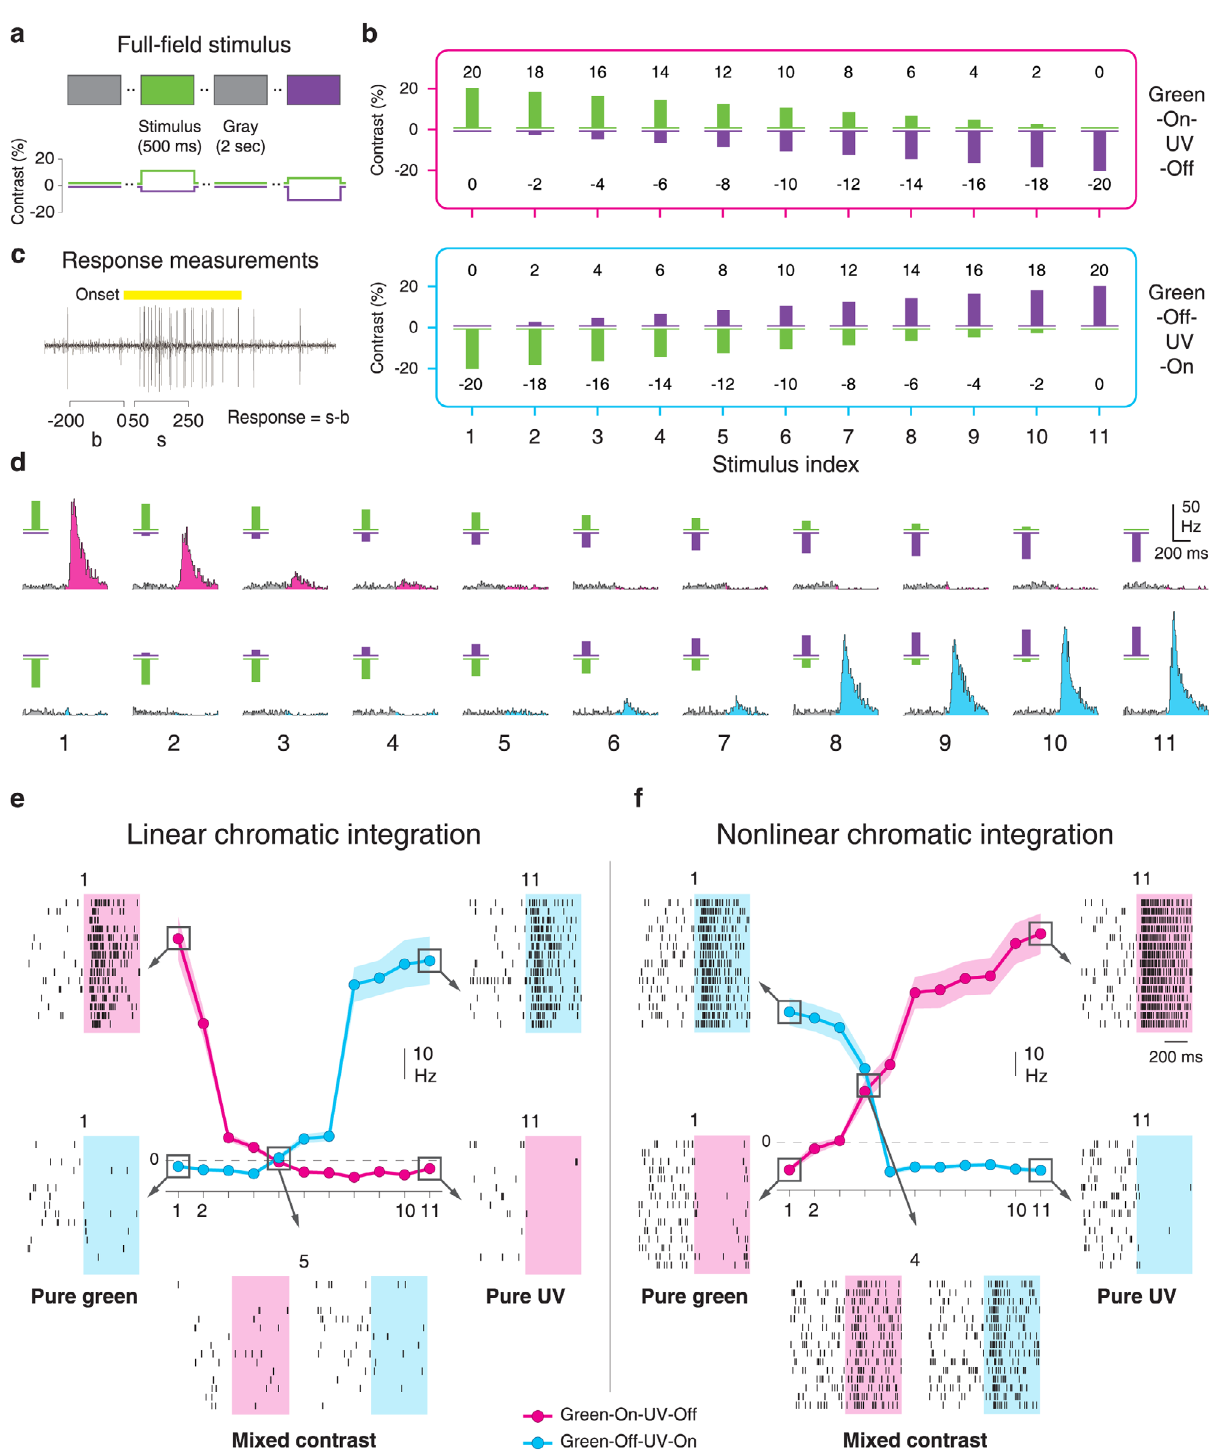
Fig. 2 Measurement of chromatic integration. a Schematic representation of the chromatic-integration stimulus. 500-ms presentations of opposing contrast of UV and green were interleaved with 2 s of background illumination (gray). b Schematic depictions of all contrast combinations used for assessing chromatic integration. The contrast combinations are arranged into two sets, corresponding to green-On-UV-Off (magenta box, top) and to green-Off-UV-On (blue box), with pairs of contrast-reversed combinations vertically aligned and assigned to a stimulus index (1 – 11). c Response measurements used for constructing the chromatic-integration curves. Spike counts (s) were obtained over a 200-ms window during stimulation (50 – 250 ms after stimulus onset), and the background activity (b), measured as the spike count during the 200 ms prior to the stimulus, was subtracted (s − b). The yellow bar shows the stimulus period. d PSTHs for a sample On cell responding to the contrast combinations of the chromatic-integration stimulus (below: stimulus indices 1 – 11). e Chromatic-integration curves for the same cell as in d , surrounded by exemplary raster plots for some of the contrast combinations. At the balance point, activity is canceled out, which indicates linear chromatic integration. f Same as e , but for a sample Off cell with sizeable responses at the balance point, which indicates nonlinear chromatic integration. Shaded regions around the data curves mark the range of mean ±